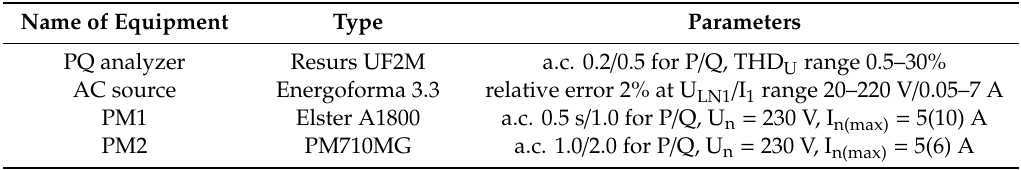
Table 1. The equipment used in the laboratory